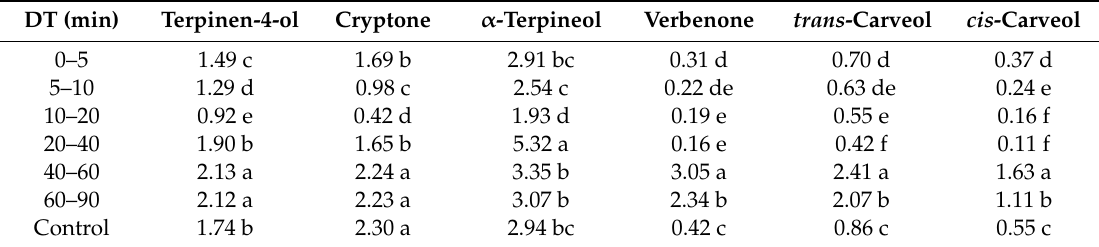
Table 9. Mean concentrations (%) of Hyssopus o ffi cinalis subsp. aristatus EO (terpinen-4-ol, cryptone, α -terpineol, verbenone, trans -carveol, and cis -carveol) obtained from the seven distillation times (DT). Control = nonstop 0–90 min.